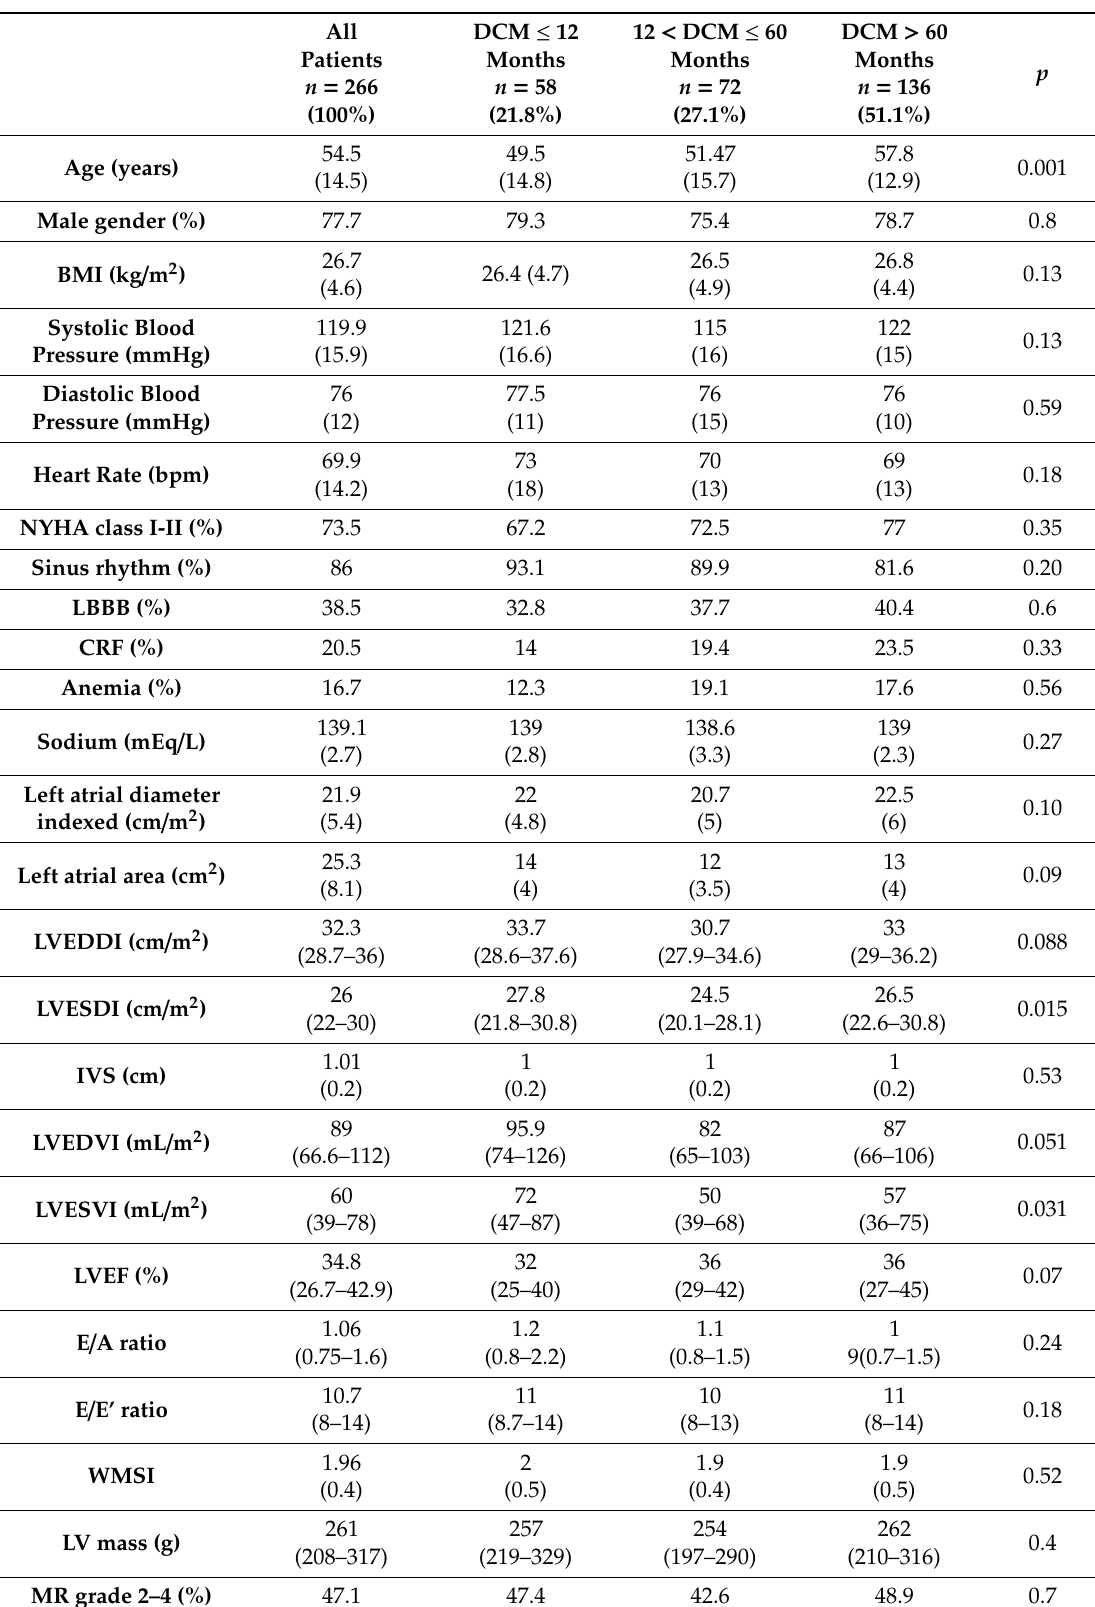
Table 3. Main characteristics of patients stratified by DCM